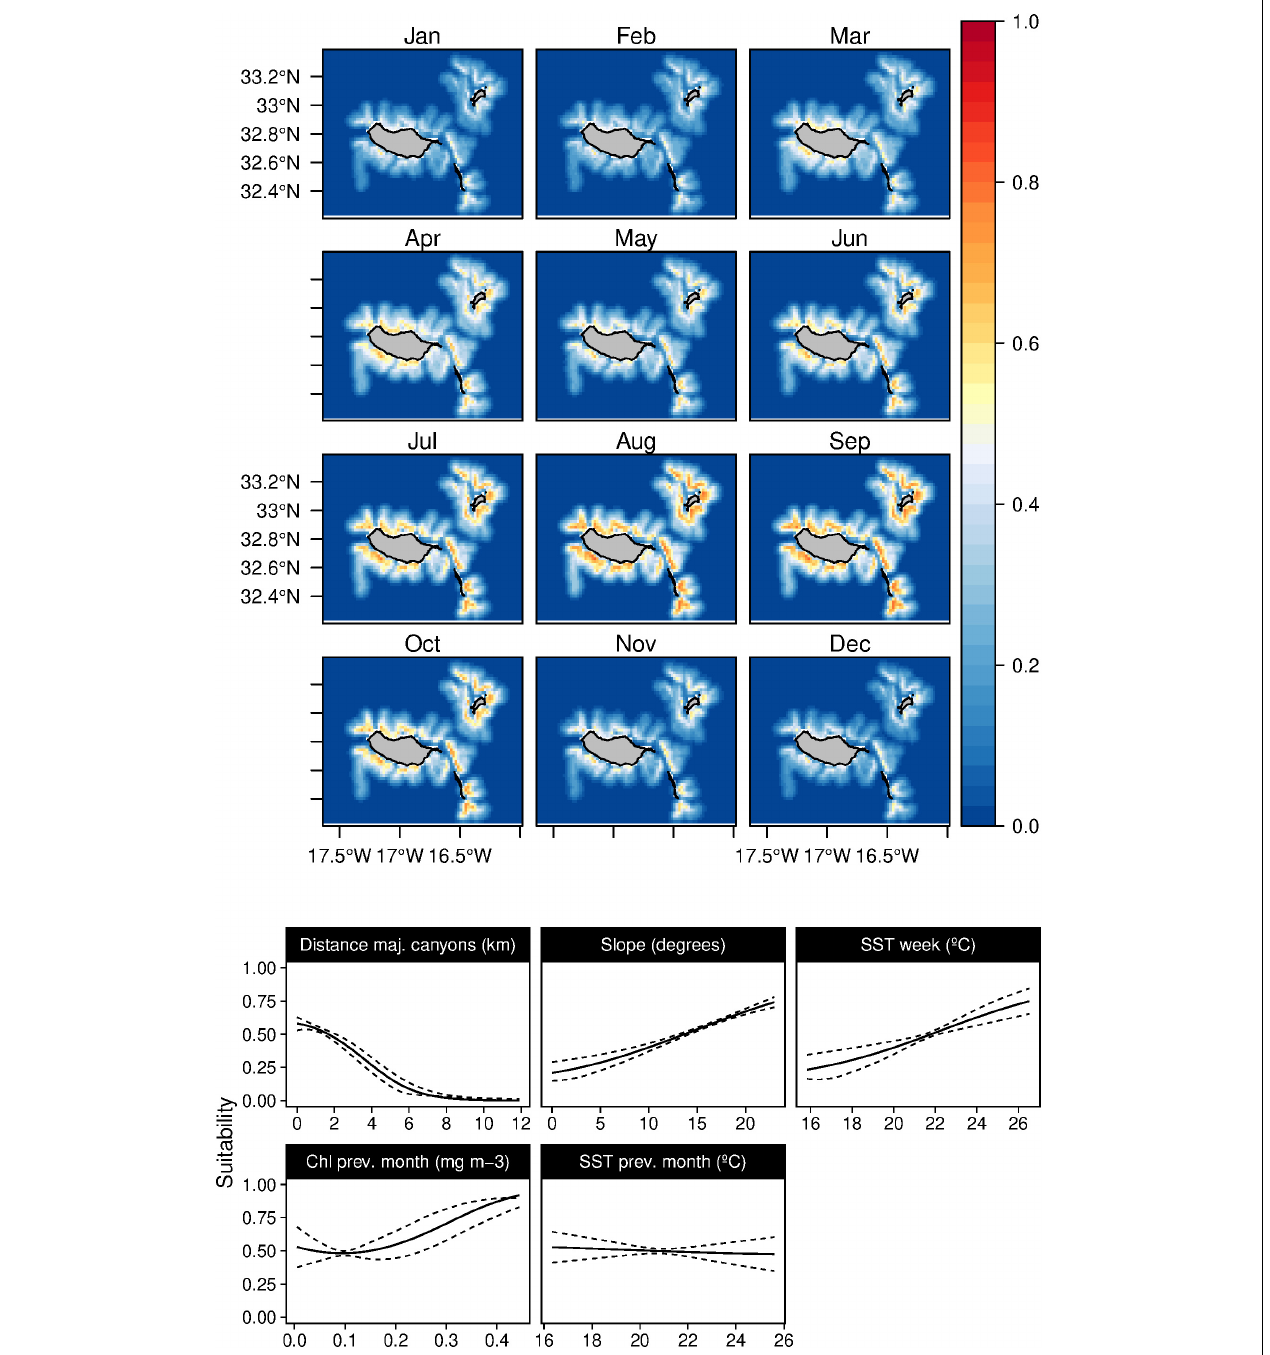
FIGURE 4 | Mean monthly suitability maps (above) and smoothed response curves with standard deviation (below) in the Madeira archipelago for Mesoplodon densirostris for the “8-days” models. In the maps, red represents more suitable and blue less suitable. Responses curves are ordered by percent contribution of the environmental